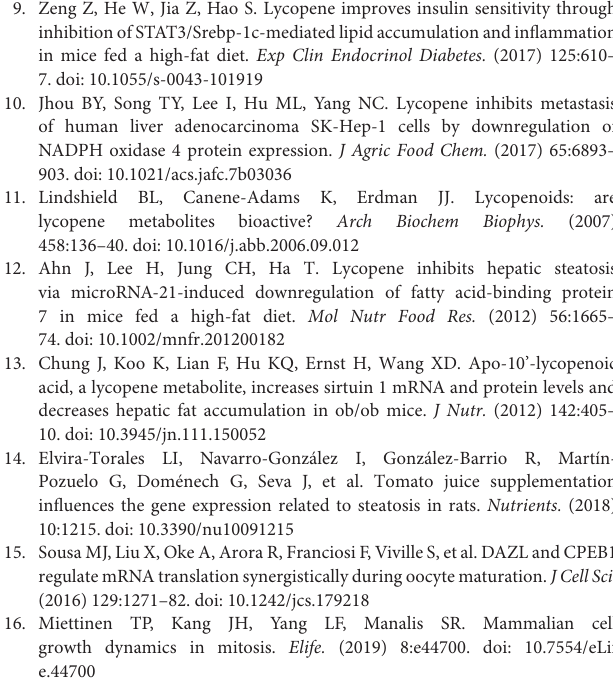
Supplementary Figure 1 | KEGG pathway diagram, (A) oxidative phosphorylation pathway. (B) Non-alcoholic fatty liver disease pathway. Red represents DEGs. Supplementary Figure 2 | Principal component analysis (PCA) in RNA-seq. Supplementary Figure 3 | Volcano plots of DEGs in RNA-seq, |log 2 fold change| > 1 and p < 0.01. Supplementary Figure 4 | The scatter plot of correlation between mRNA abundance and RPF abundance. Red: HFD; blue: LYC. Supplementary Table 1 | Nutritional composition of mice feed. Supplementary Table 2 | Differentially expressed genes in Ribo-seq. Supplementary Table 3 | GO biological process of DEGs in Ribo-seq. Supplementary Table 4 | KEGG pathways of DEGs in Ribo-seq. Supplementary Table 5 | Differentially expressed genes in RNA-seq. Supplementary Table 6 | The gene information in different